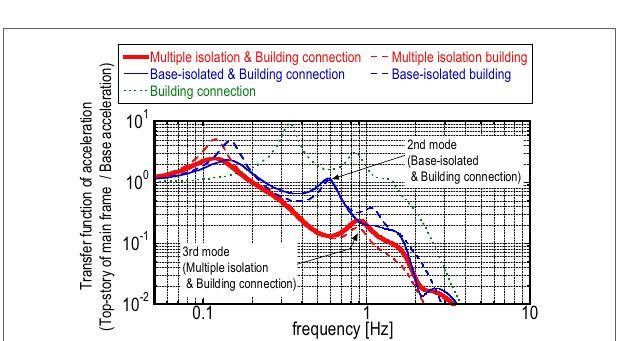
FIGURE 5 | Transfer function of acceleration (top-story of main frame/base acceleration) .